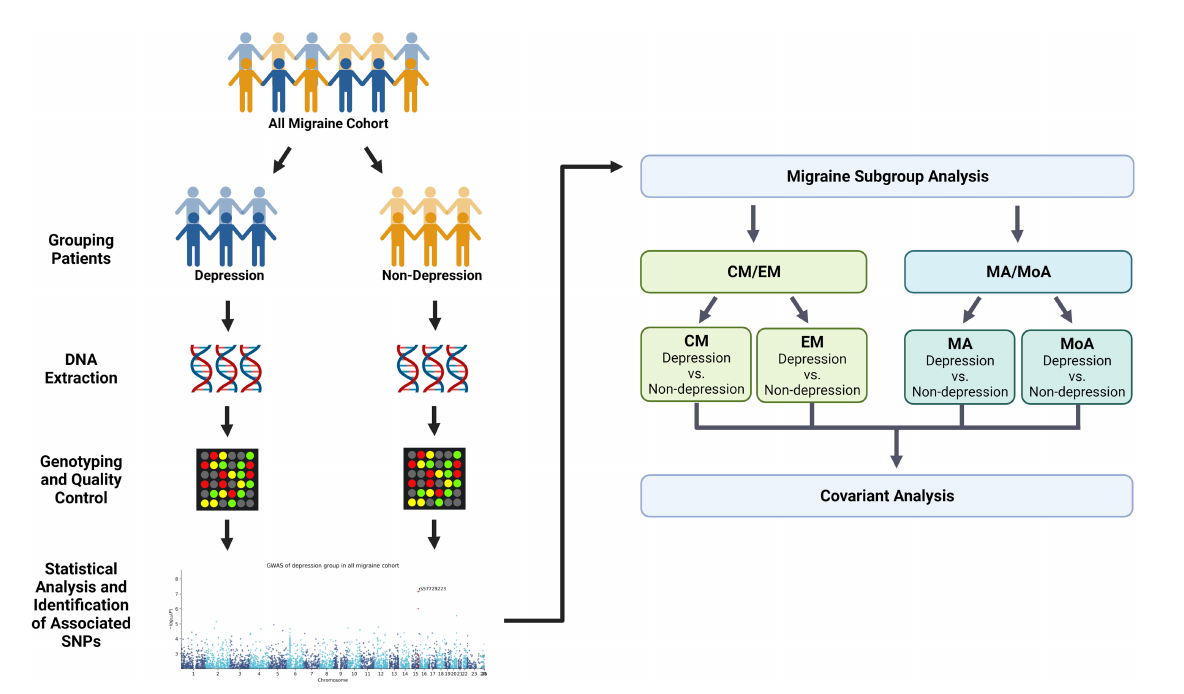
FIGURE1 Flowchart showing the pipeline of the covariant analysis in depression and migraine. We divided migraine patients into two groups (non-depression and depression) and performed the first phenotype association study with depression ( Table 2 ). Next, samples were stratified into four migraine subtypes: episodic migraine (EM), chronic migraine (CM), aura (MA), and non-aura (MoA). Each group was further divided into two subgroups based on the presence and absence of comorbid depression. The results of the quantitative trait study in the second stratification are shown in Table 3 . Finally, we compared the variants in the migraine group and subgroups to summarize the covariant in the study. This figure was created with Biorender.com.